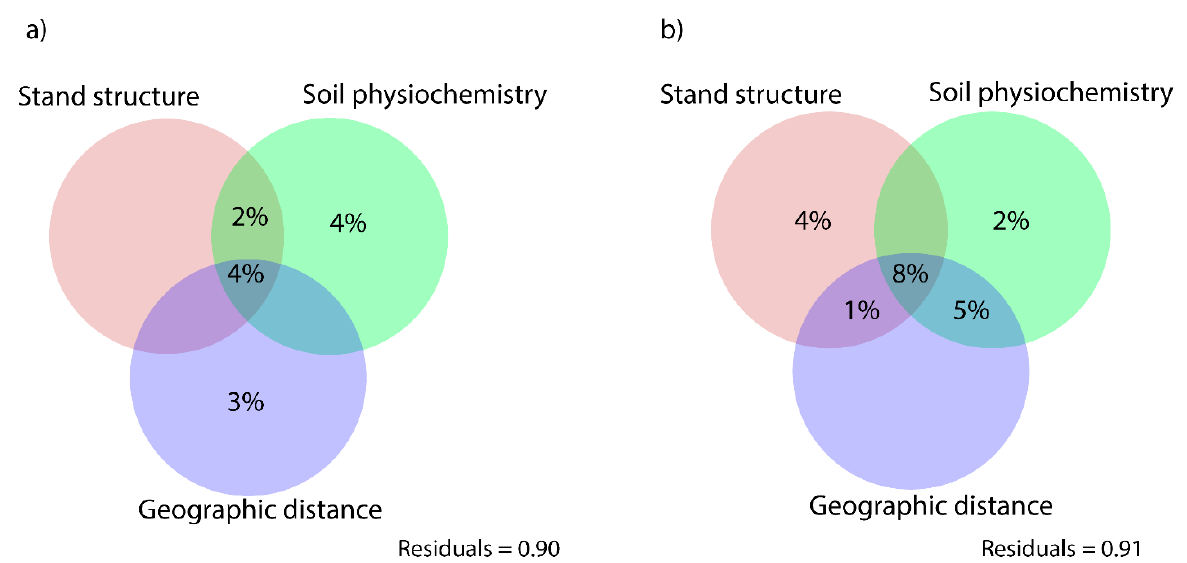
Figure 4. Variance partitioning analyses for ( a ) ectomycorrhizal phylogenetic composition and ( b ) ectomycorrhizal phylogenetic structure (NRI, NTI indices) in response to stand structure, soil physiochemistry and geographic distance. Values show the fraction of variation explained by each group of parameters, as well as the shared contribution of each combination of them.